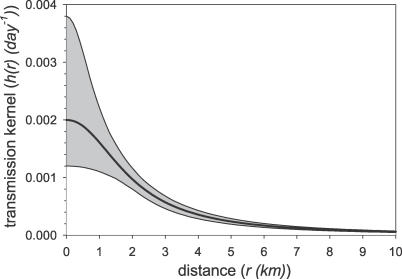
The Transmission Kernel as a Function of Interfarm Distance for the Parameter Estimates of Table 1
The 95% confidence areas of the transmission kernel are represented by the shaded area.